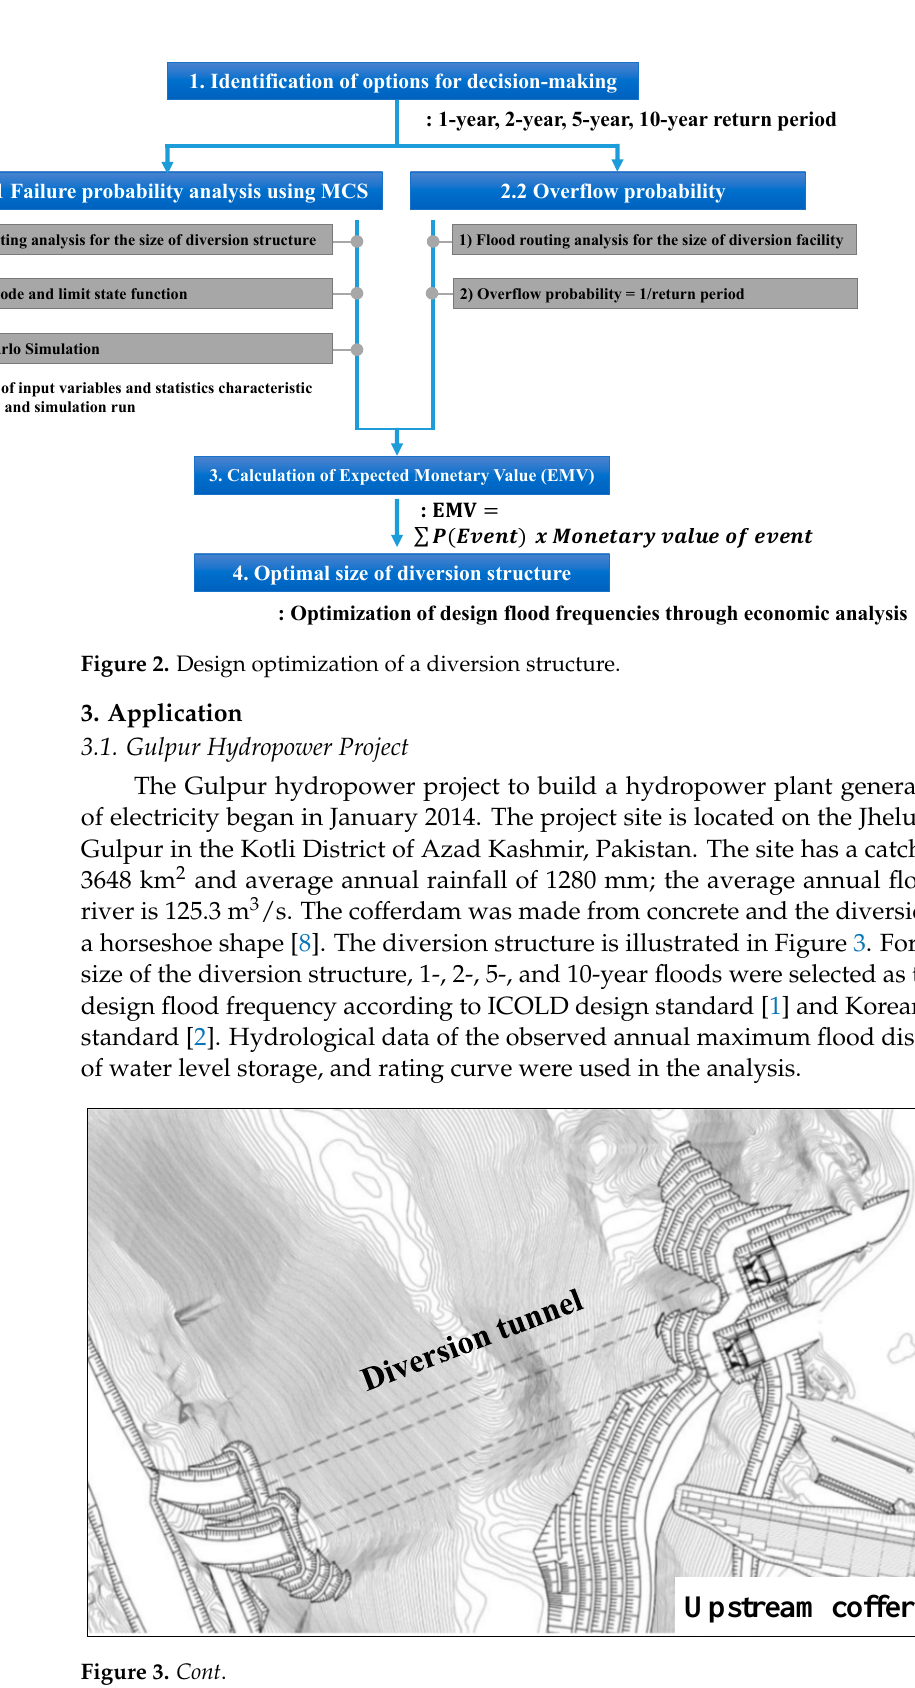
Figure 3. Diversion structure. 3.2. Failure Probability Analysis using MCS 3.2.1. Flood Routing Analysis Flooding routing analysis derives an outflow hydrograph from an inflow hydro- graph for an upstream cofferdam with consideration of the elevation, storage, and dis- charge characteristics of the diversion tunnel. The conservation-of-mass equation is solved assuming that the outflow discharge and volume of storage are directly related. The diameter or the number of diversion tunnels and the height of the cofferdam are de- termined using flood routing analysis. In this paper, the diameter of the diversion tunnel is set at 10 m, which is the limit of full-face excavation, and the optimal combination of cofferdam height and the number of diversion tunnels in terms of construction cost is obtained. In addition, 1 m freeboard is included to determine the height of the upstream cofferdam. Using flood routing analysis, the optimal combination of the cofferdam height and the number of diversion tunnels are calculated as shown in Table 1.